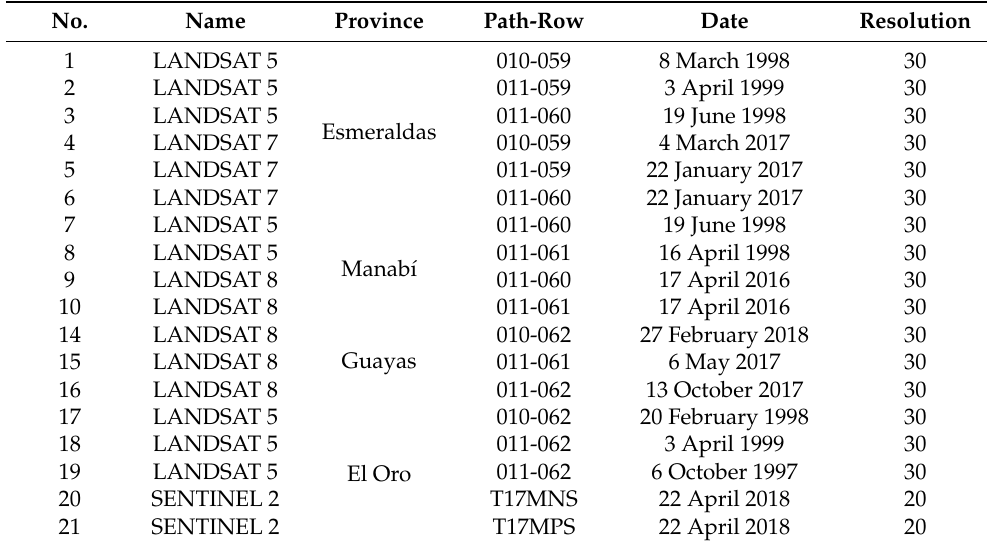
Table 1. Medium-resolution imagery used in this study.